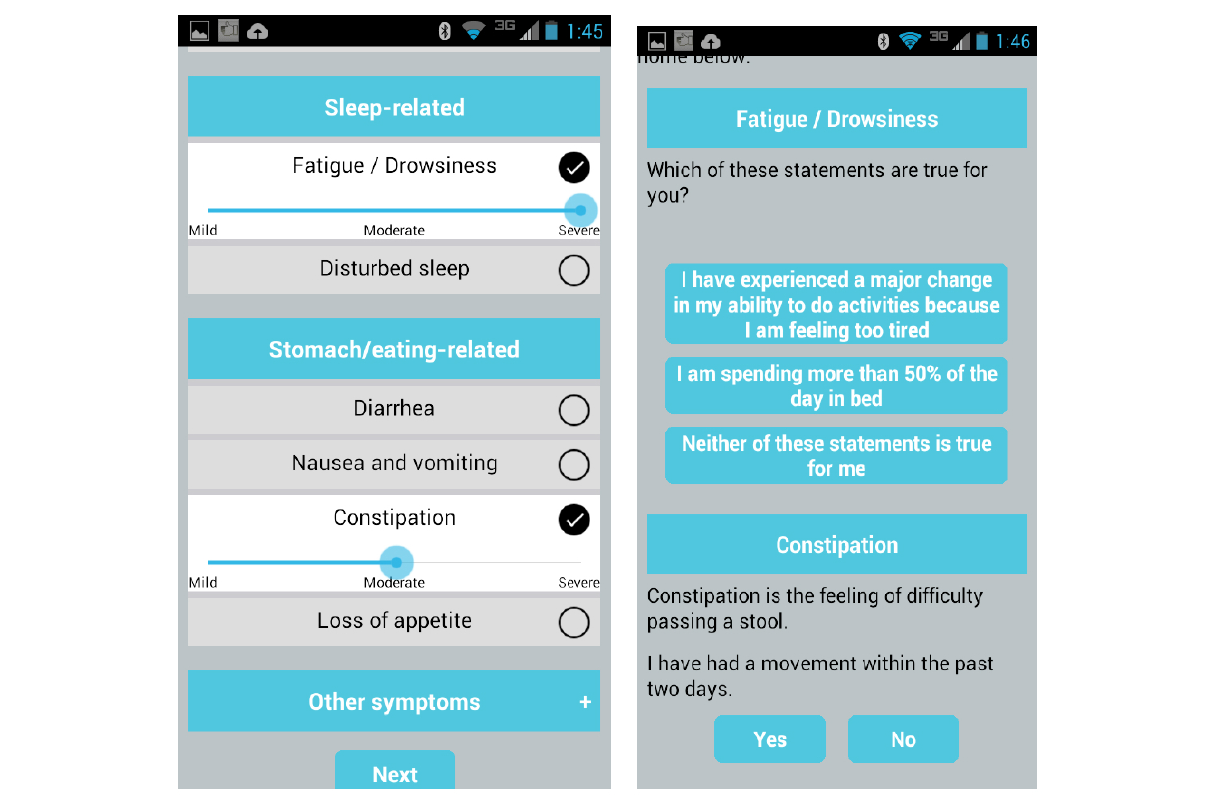
Figure 3. Ad hoc symptom